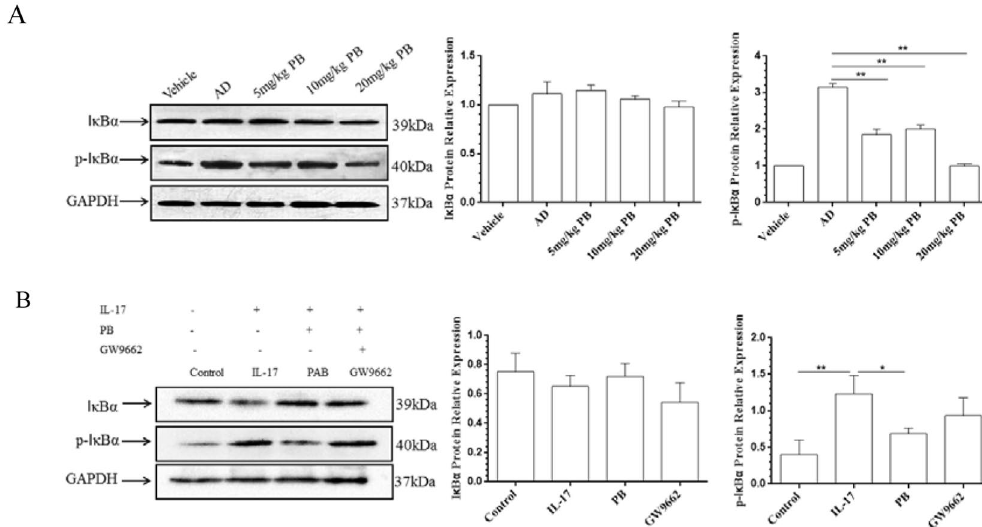
Figure 10. Effect of PB on the phosphorylation of I κ B α . ( A ) The relative expression levels of I κ B α and phospho-I κ B α (p-I κ B α ) in the lesional skin tissues of NC/Nga mice were detected using western blot analysis. GAPDH was used as an internal control. Vehicle, intact mice with saline treatment; AD, DNFB-sensitized and challenged mice; PB, pseudolaric acid B. ( B ) RAW264.7 cells were pre-incubated with GW9662 (1.0 μ mol/l) for 1 h before added with PB (0.5 μ mol/l). After 21 h, cultured cells were stimulated with IL-17 (10 ng/ml)